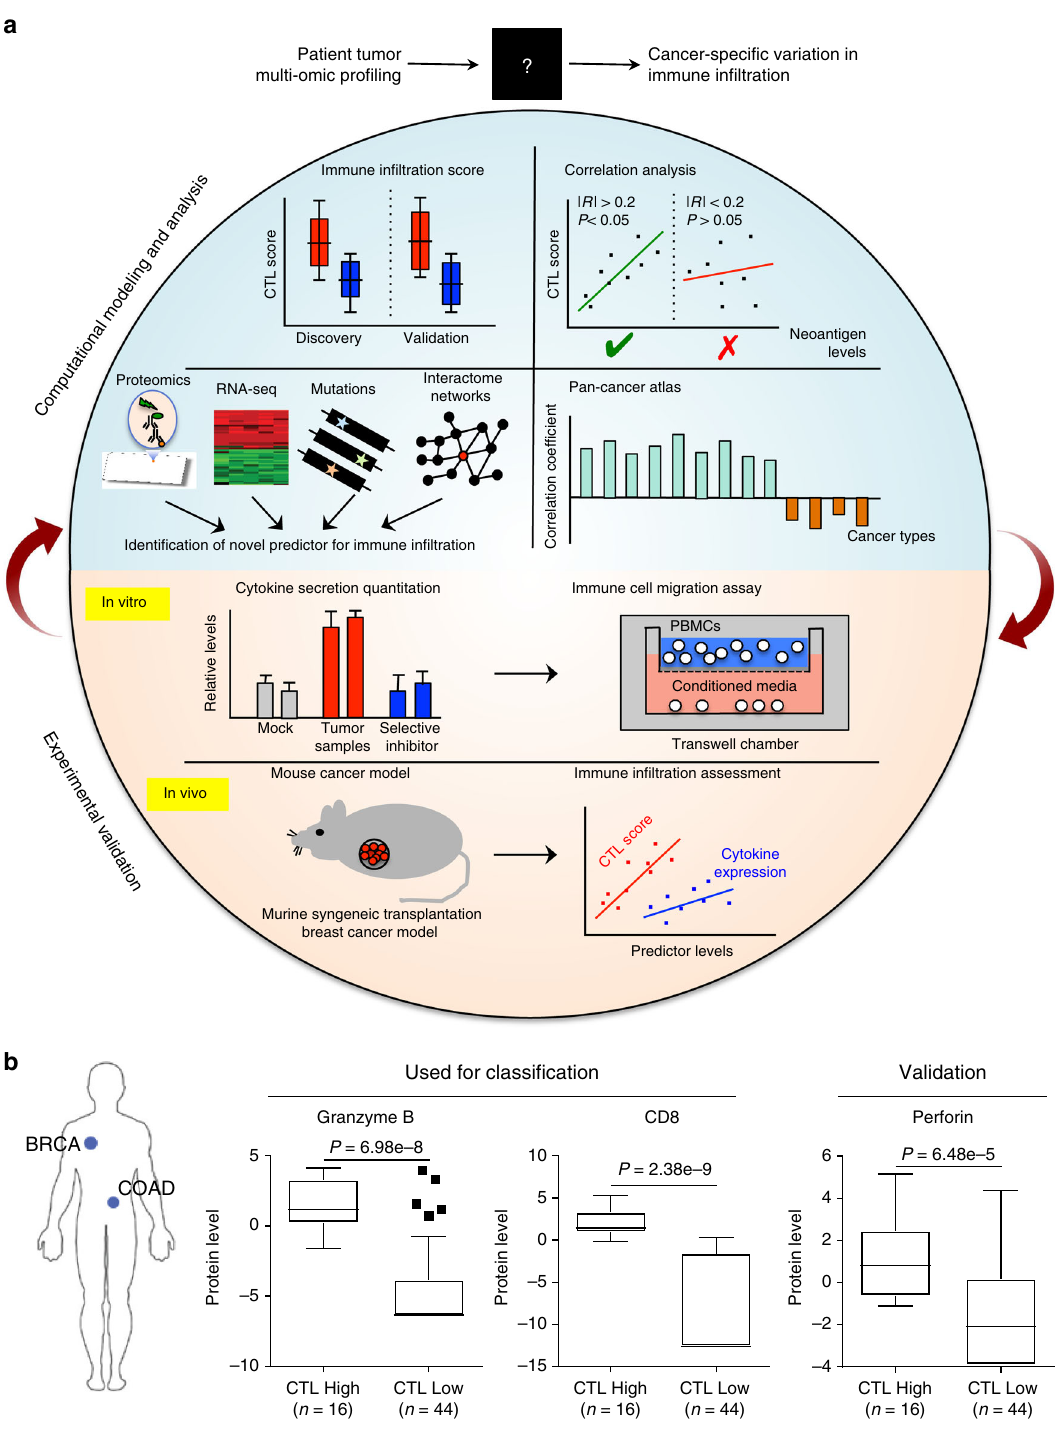
Fig. 1 Integrative multi-omics network analysis framework to reveal determinants of immune in fi ltration across human cancers. a Flow chart for analysis of pan-cancer indicators of immune invasion. Cytotoxic T-cell (CTL) levels were determined from proteomic data and integrated with gene expression, genetic mutations, phospho-/total- proteomics, and interactome networks. Identi fi ed markers were then expanded pan-cancer, and potential novel drivers were experimentally veri fi ed. b Protein data sets and classi fi cation of CTL high patients. CTL high breast cancer patients were classi fi ed by positive expression of the cytolytic enzyme granzyme B and CD8 CTL surface marker, and also showed enrichment of the cytolytic enzyme perforin. P values were determined by Wilcoxon rank-sum test. Box indicates median with interquartile range, and whisker length determined by the Tukey ’ s